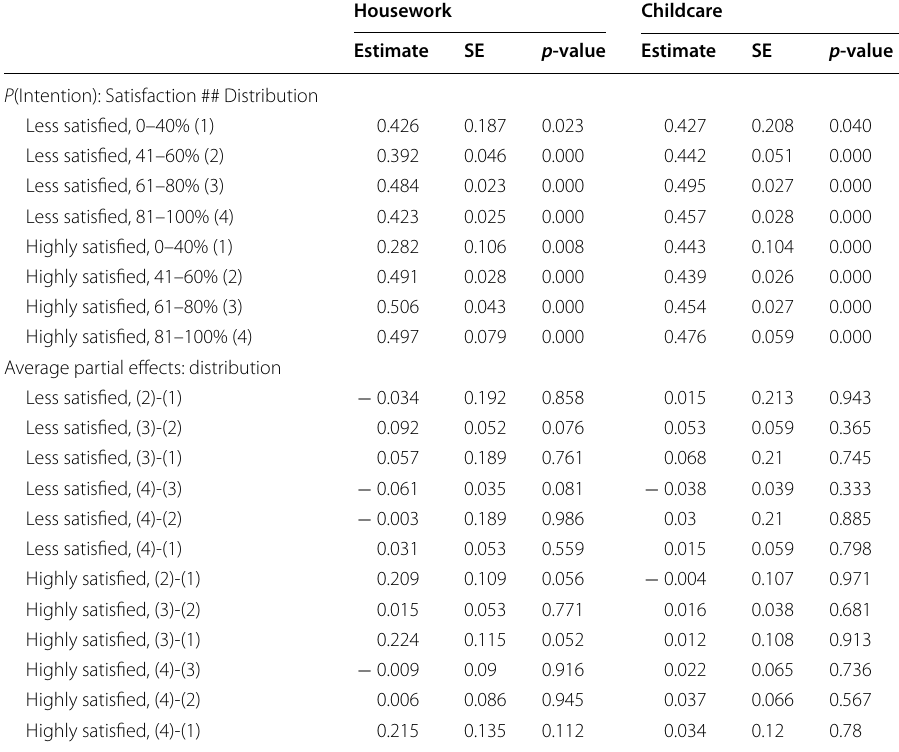
Table 5 Predicted probabilities and average partial effects of the interaction in Model 2 Housework Childcare